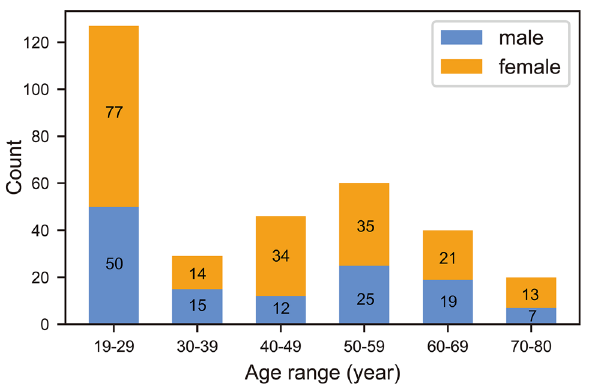
Figure 3. The distribution of participants based on age and sex. The exact number of each group is shown in the corresponding bar.